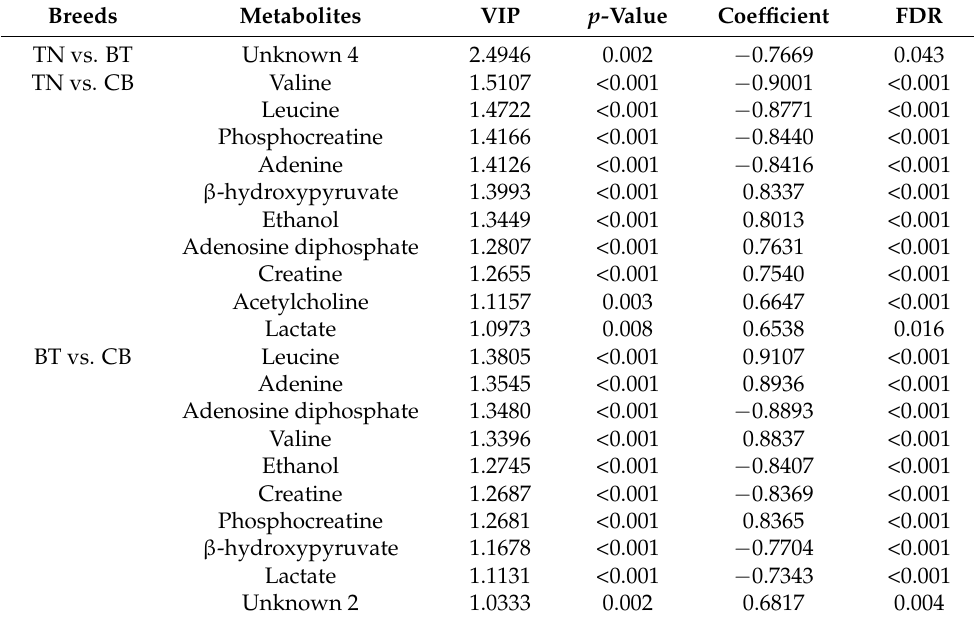
Table 5. A possible biomarker for separating meat metabolites from three distinct breeds. Breeds Metabolites VIP p-